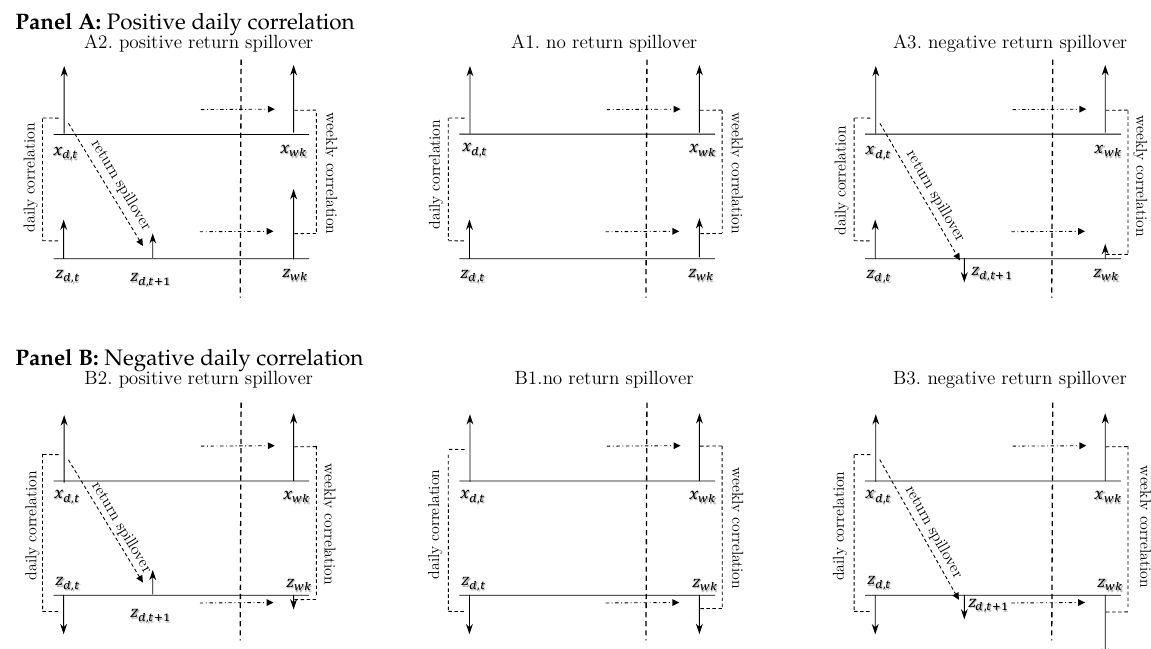
Figure 4. How return spillovers affects assets’ return correlation. This figure illustrates the proposed channels through which return spillovers at daily frequency affect correlation at weekly frequency. We use “daily” and “weekly” for the illustration purpose; the results also apply to other relative “high” and “low” frequencies. For example, Panel A2 shows how a daily ( d ) return spillover from X to Z causes the weekly ( wk ) return of Z to increase (illustrated by a longer arrow) and thus leading to a higher co-movement of X and Z at the weekly level. The increased co-movement of X and Z (longer arrows of X and Z ) can be seen by comparing A2 with the benchmark A1 (the no return spillovers